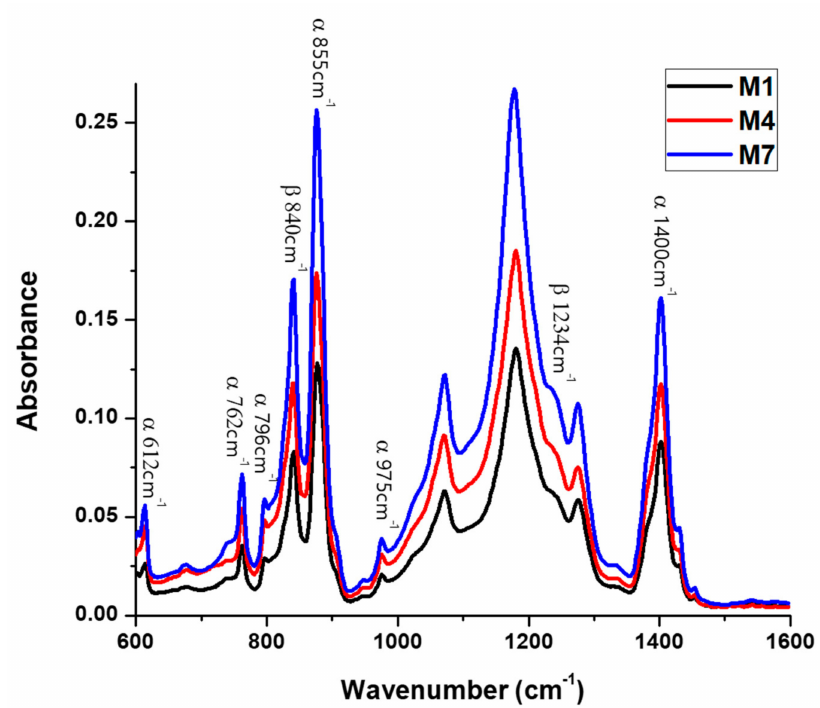
Figure 2. FTIR-ATR spectra of characteristic peaks for α and β phases of the top membrane surfaces of M1, M4, and M7, prepared at the same temperature using PVDF with different molecular